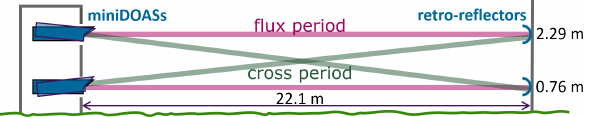
Figure 3. MiniDOAS set-up in the field, using two instruments at different heights above the ground. The NH 3 flux is determined from the observed concentration difference between the top and bottom paths and the turbulence measurements of sonic #1 (flux period, shown in purple). Shown in green are the two instruments in cross-position (cross period). These zero-difference measurements are used for the precise intercalibration needed for flux measure- ments (see